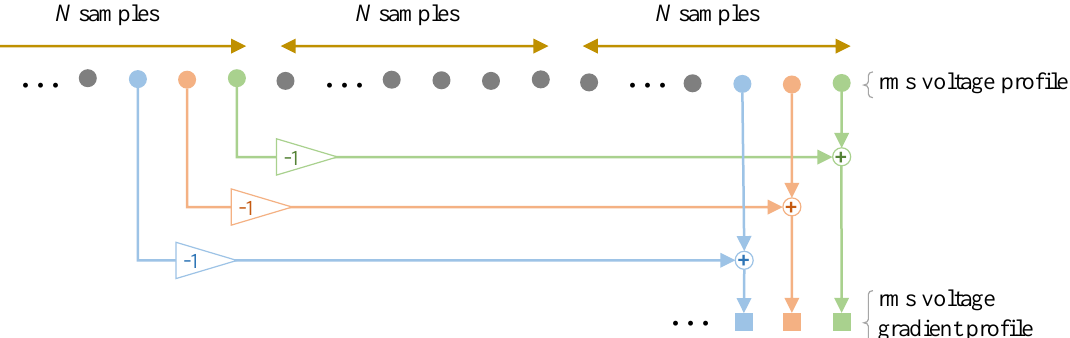
Figure 3. Illustration of the root-mean-square (RMS) voltage gradient profile computation for p =